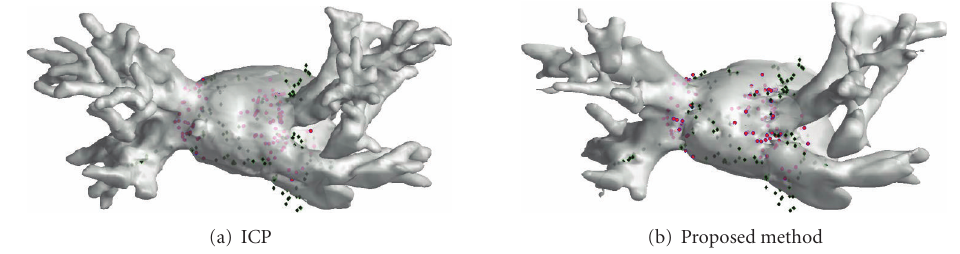
Figure 6: The surface registration results for the patient data.